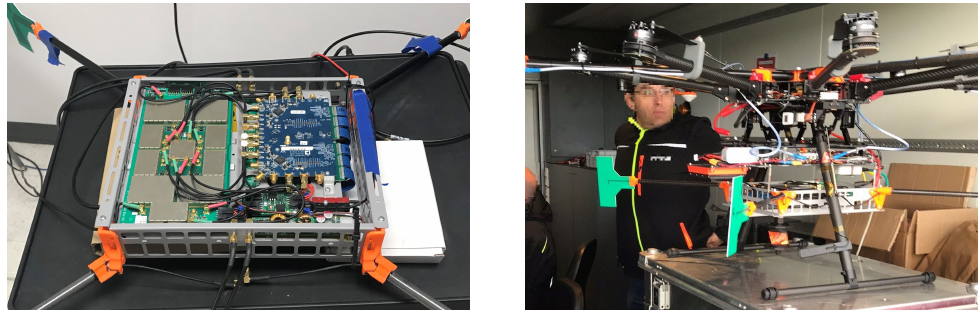
Figure 2. Initial hardware prototype of the CHP2 system: ( left ) the ZCU102 evaluation kit and FMCOMMS5 RF evaluation board installed in a folded sheet metal case, with dimensions 20 cm × 20 cm × 5 cm, and ( right ) the CHP2 assembly mounted to the DJI S1000+ UAV for flight